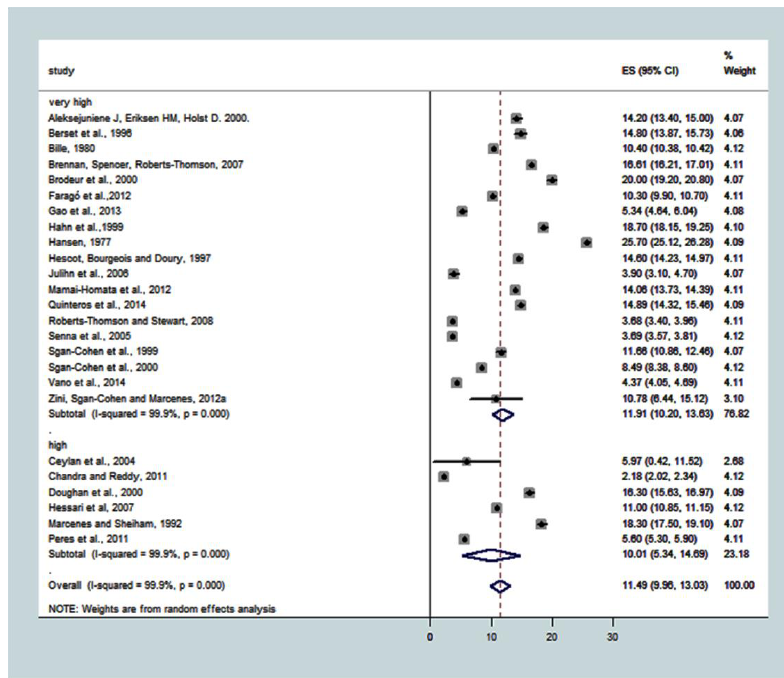
Figure 3. Association between HDI and caries experience (DMFT). Pooled effect estimates from the random-effects meta-analysis are shown. Heterogeneity was assessed using the χ 2 test and I 2 statistics. The forest plots are comparing caries in adults from countries with very high compared to high and medium DHI.